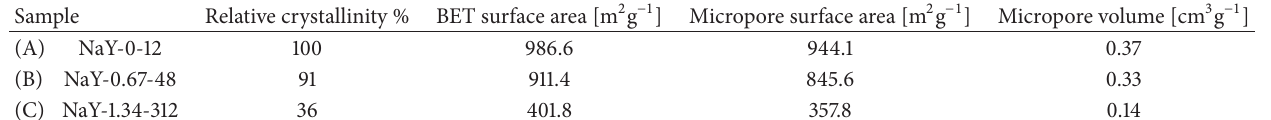
Table 2: Textural parameters of the samples obtained at different H 2 SO 4 /Al 2 O 3 .